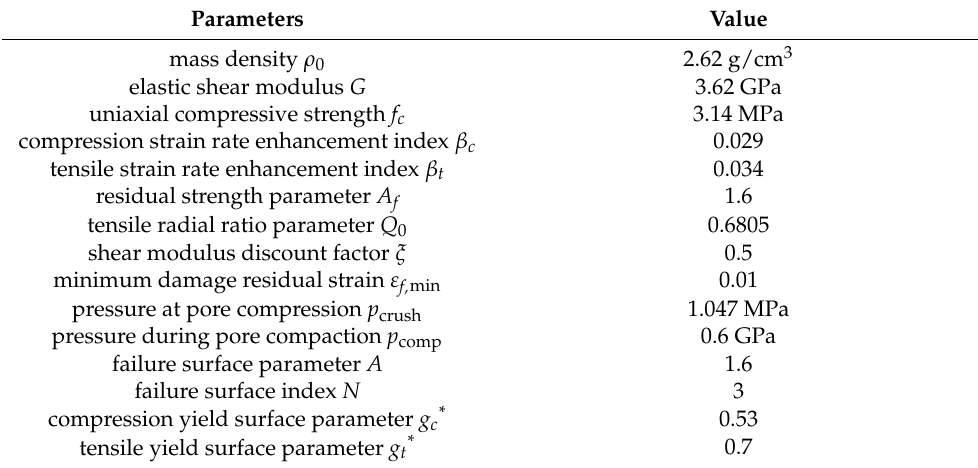
Table 4. RHT model parameters.